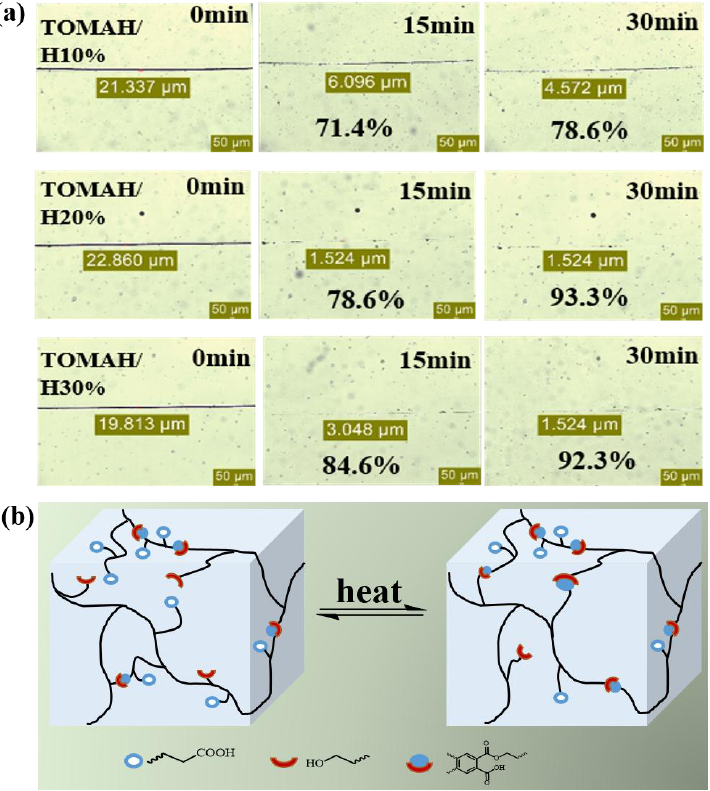
Figure 5. ( a ) Thermal-repairing procedures of the UV-cured TOMAH/H samples with time under stress-free condition. ( b ) Illustration of self-healing